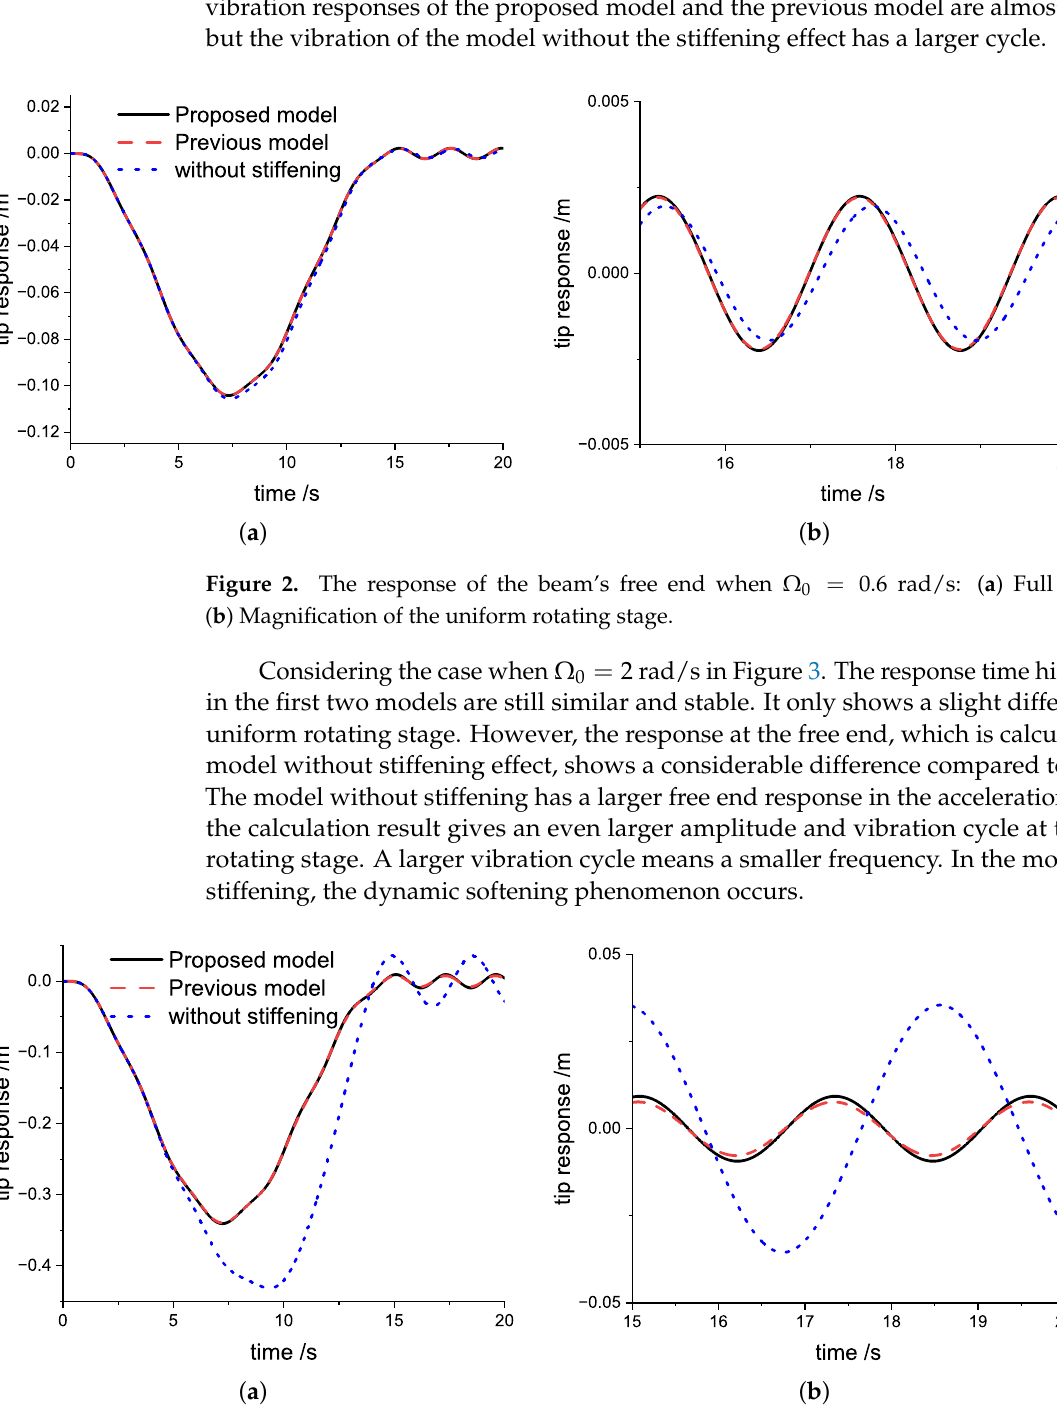
Figure 3. The response of the beam’s free end when Ω 0 = 2 rad/s: ( a ) Full time period; ( b ) Magnification of the uniform rotating